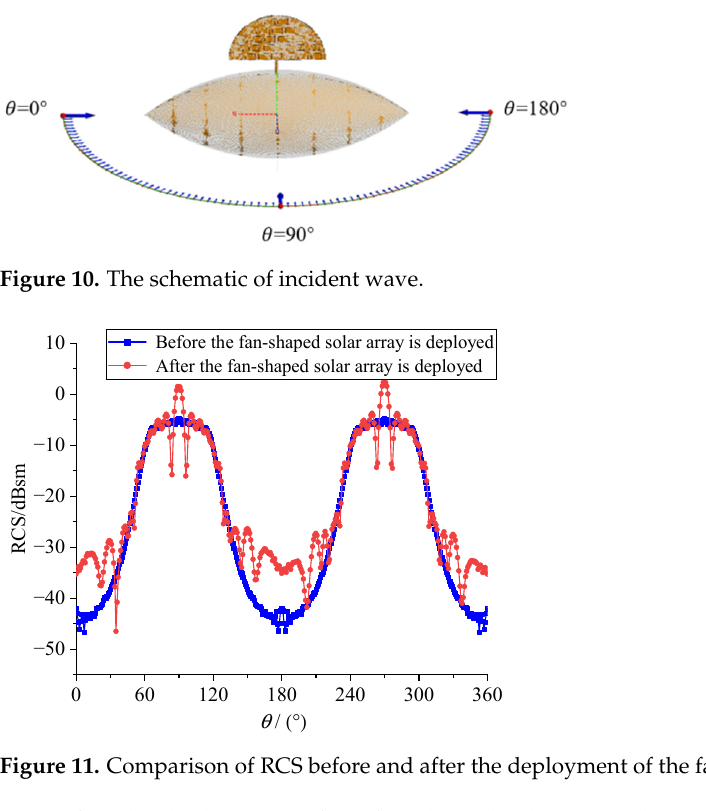
Figure 11. Comparison of RCS before and after the deployment of the fan-shaped solar array. After the deployment of the fan-shaped solar array, the backscattering becomes sig- nificantly stronger when the radar wave is vertically incident the combination of the solar array and the satellite, resulting in an increase in RCS from − 4.63 dBm to 2.57 dBsm, an increase of 7.2 dBsm. In addition, RCS in the angular domain around 180 ◦ also rises to a certain extent, which is the contribution of specular reflection and edge diffraction of the solar array, and the RCS in the remaining angular domain basically overlaps. It can be seen that although the fan-shaped solar array increases the RCS in the small angle domain, the damage to the overall stealth performance of the satellite is small, and due to the covering of the solar array by the satellite, the ground-based radar wave within a certain angle range cannot be directly incident into the fan-shaped solar array, which has certain advantages over the traditional solar array in terms of configuration